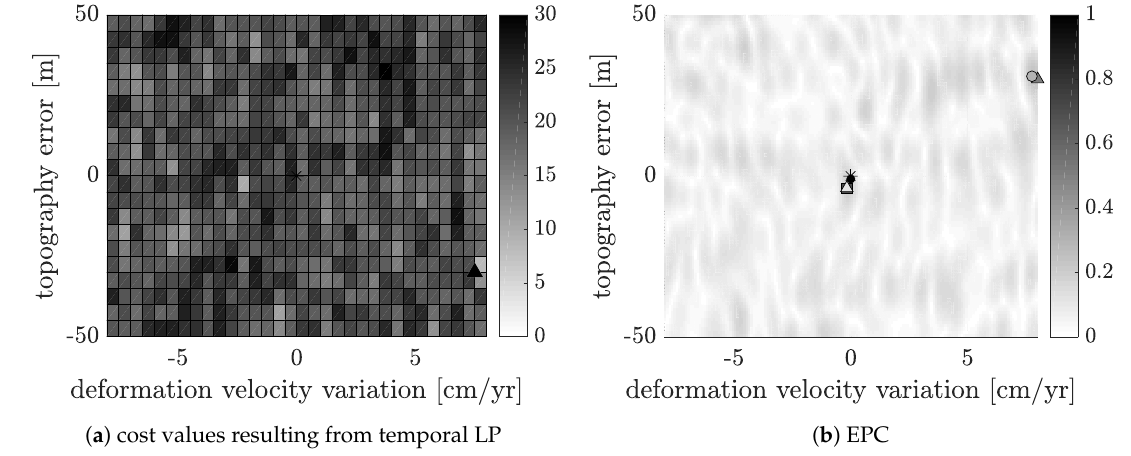
Figure 14. Cost values and corresponding EPC values for one spatial arc of the simulated D-InSAR stack with a noise level of 0.6rad. The black triangle in the left figure shows the results of the conventional way. The black star is the reference solution. The gray square in the right figure shows the results using the Nelder–Mead method for maximizing the EPC, the gray triangle when using the grid search method, the light gray point when using simulated annealing and the white triangle when using a modified search algorithm combining simulated annealing and the Nelder–Mead method. The black point represents the starting solution which is necessary for some